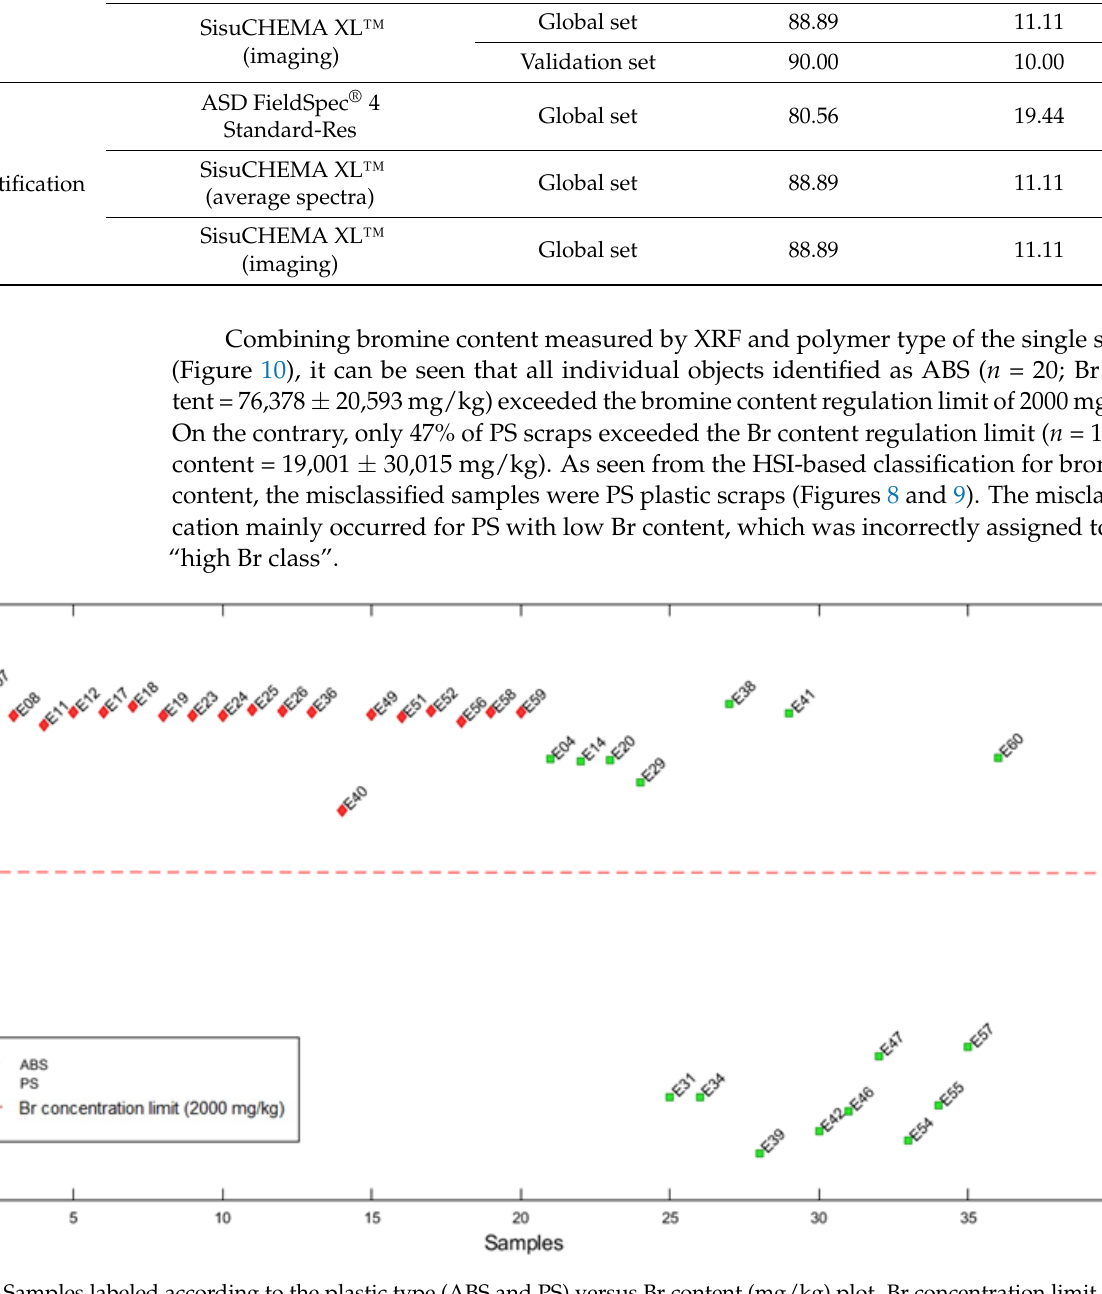
Figure 10. Samples labeled according to the plastic type (ABS and PS) versus Br content (mg/kg) plot. Br concentration limit, as reported from CENELEC technical specification (CENELEC CLC/TS 50625–3–1, 2015), is shown as a red slashed line.